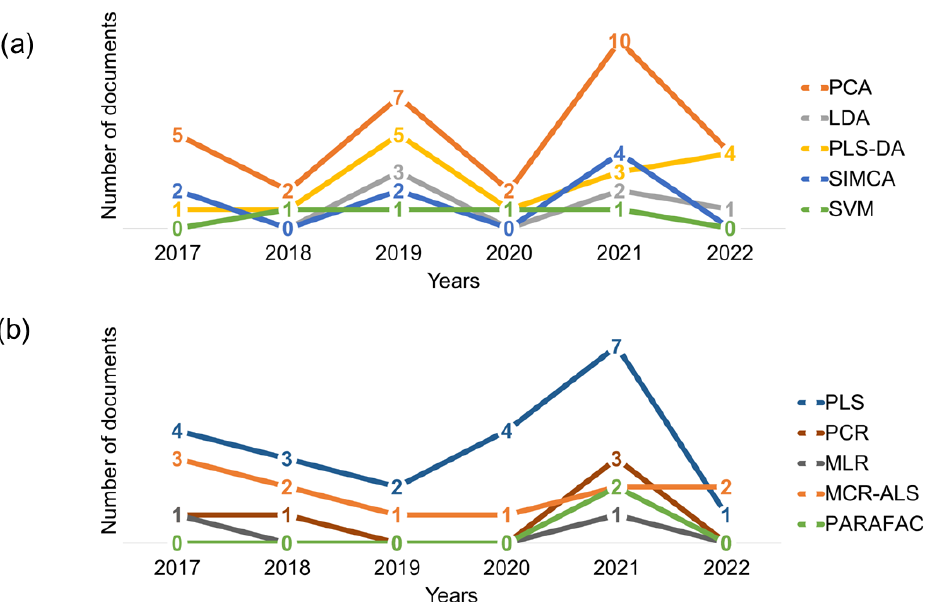
Figure 5. Number of papers per year from the last 6 years that used each algorithm considered for ( a ) pattern recognition and ( b ) quantitative approaches.